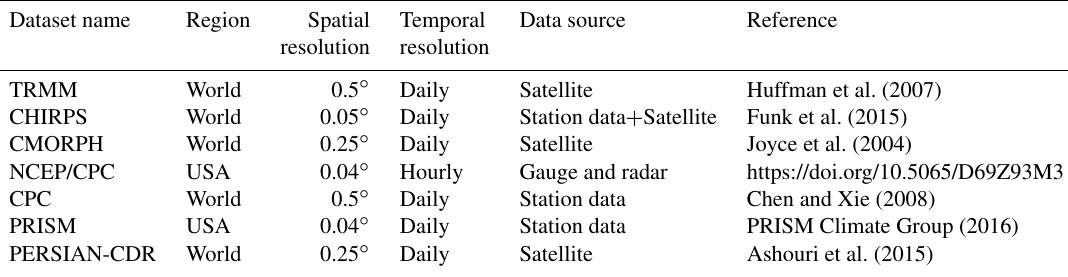
Table 3. List of observed precipitation datasets used for